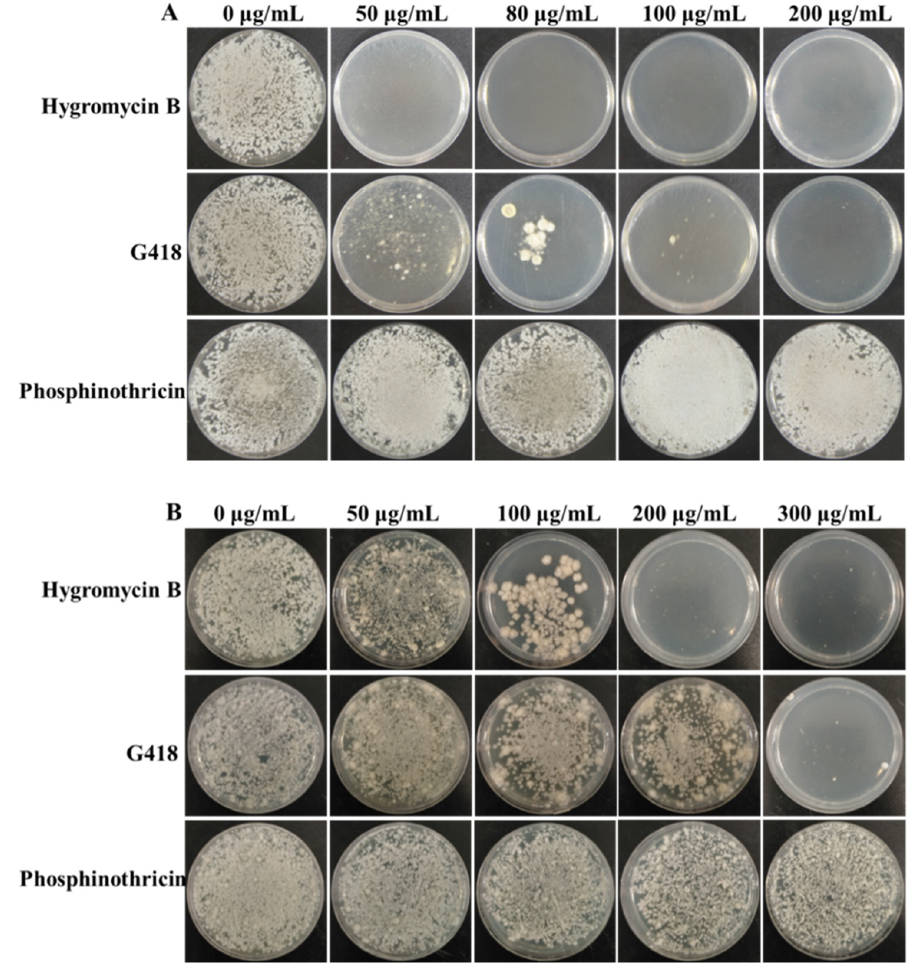
Figure 2. Marker screening for A. niger N1 and A. niger O1. ( A ) Five concentration gradients (0, 50, 80, 100, and 200 µg/mL) of three antibiotics (hygromycin B, G418, and phosphinothricin) were tested on bottom-agar plates at 30 °C for A. niger N1. ( B ) Five concentration gradients (0, 50, 100, 200, and 300 µg/mL) of three antibiotics (hygromycin B, G418, and phosphinothricin) were tested on bottom- agar plates at 34 °C for A. niger